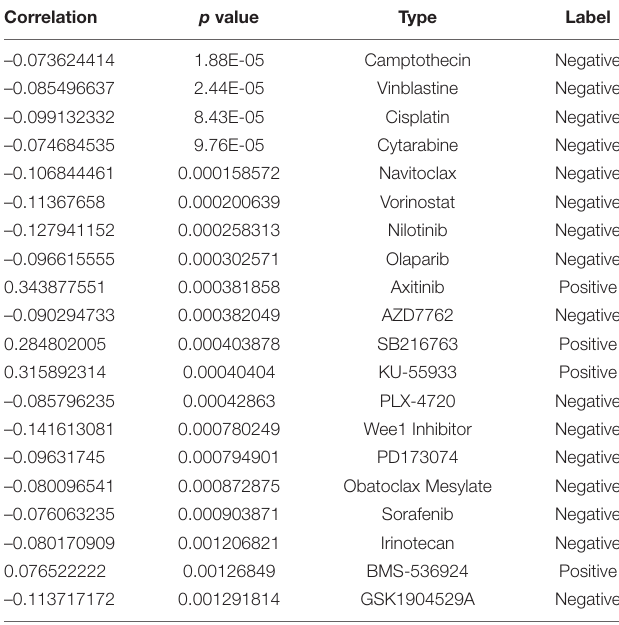
TABLE 7 | Here are the top 20 anti-tumor drug resistance studies related to